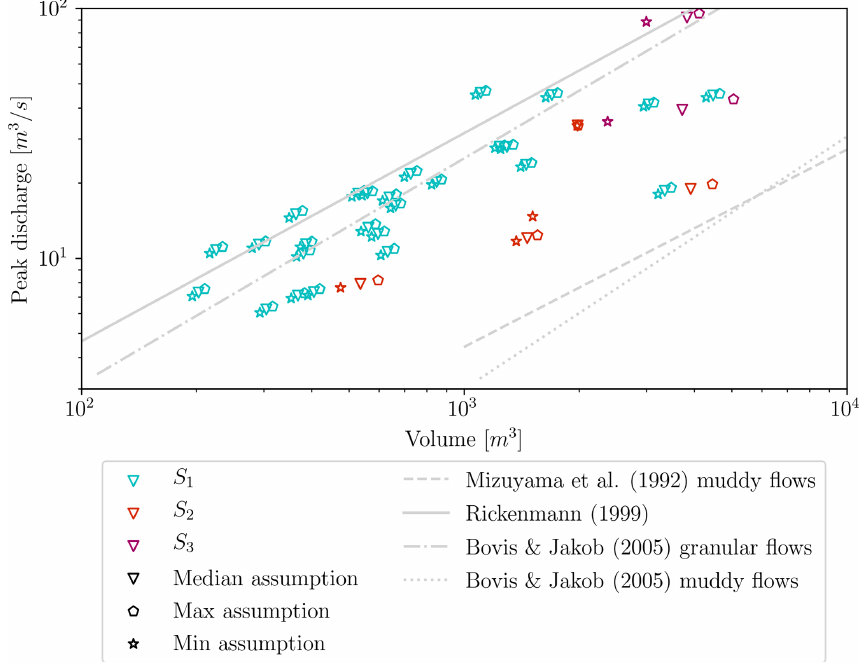
Figure 11. Relationship between debris-flow surge volume and peak discharge for all three stations of the Réal torrent (colour scale for the station and dot shape for the assumptions about the bed level): comparison with empirical fits of datasets from the literature (Bovis and Jakob, 1999; Rickenmann, 1999; Mizuyama et al.,